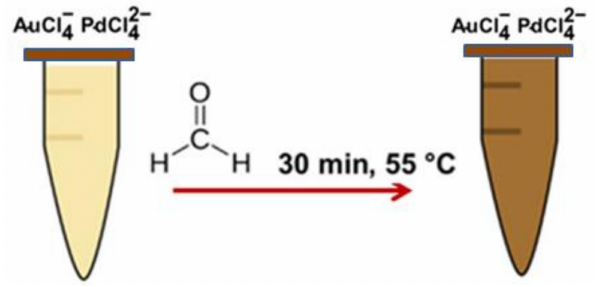
Figure 16. Colorimetric sensing with Au@PdNPs as a probe.